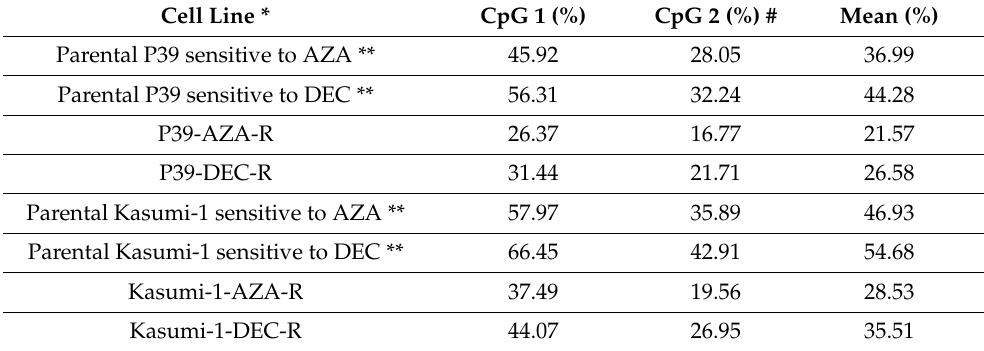
Table 2. MDM2 methylation of cell lines sensitive to and resistant to hypomethylating agents.